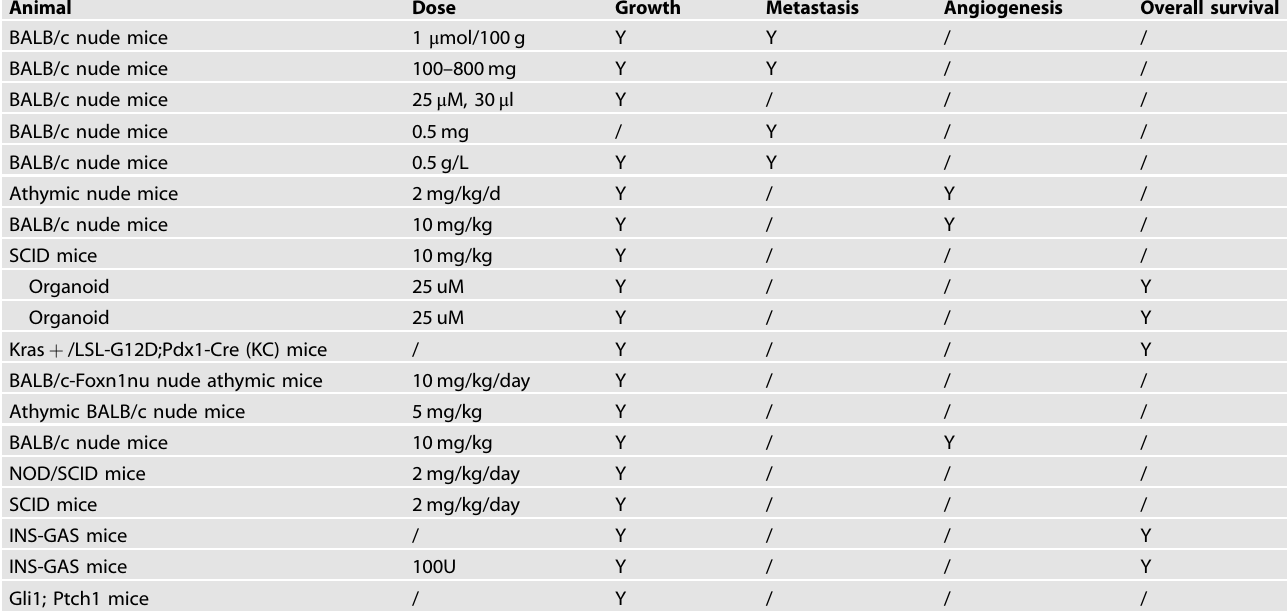
Table 1. Beta-blockers mediate the tumor development in